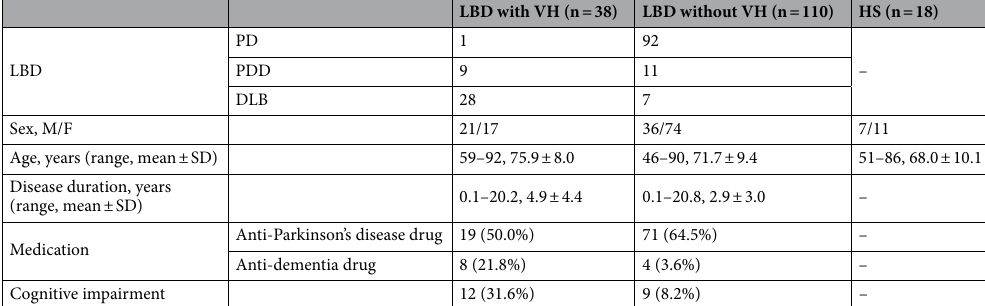
Table 1 summarizes the demographic and clinical data of the subjects.